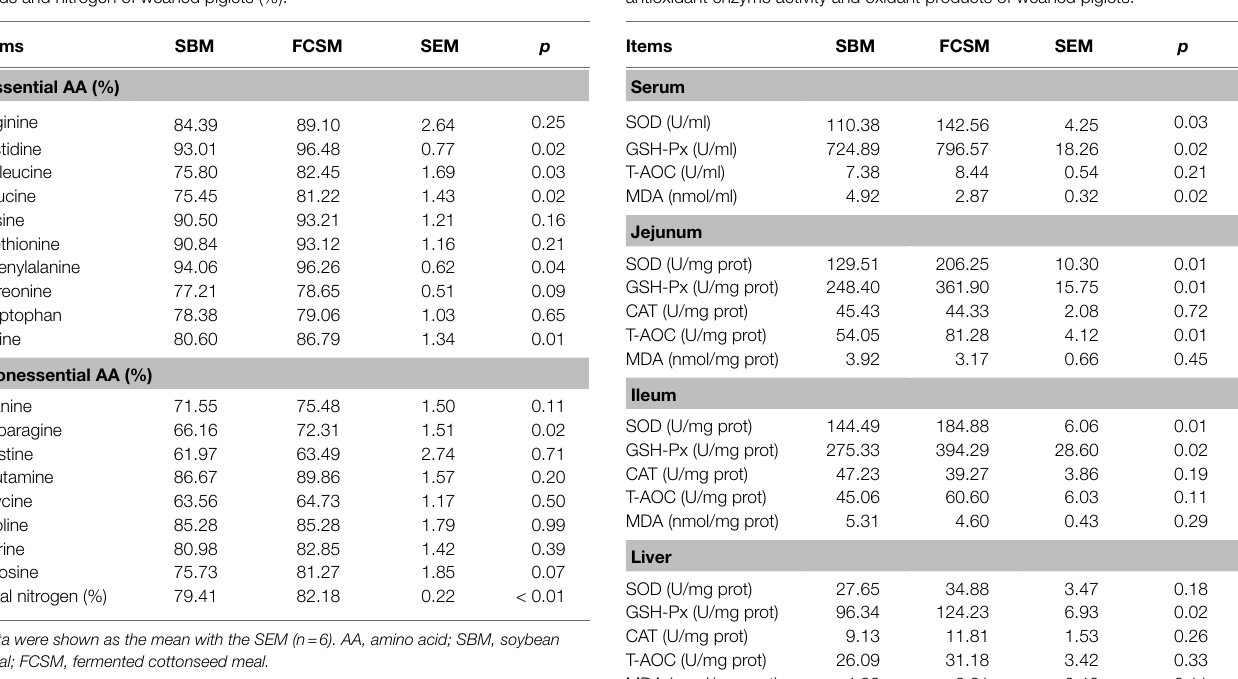
TABLE 7 | Effects of two protein source on serumal, intestinal and hepatic antioxidant enzyme activity and oxidant products of weaned piglets.